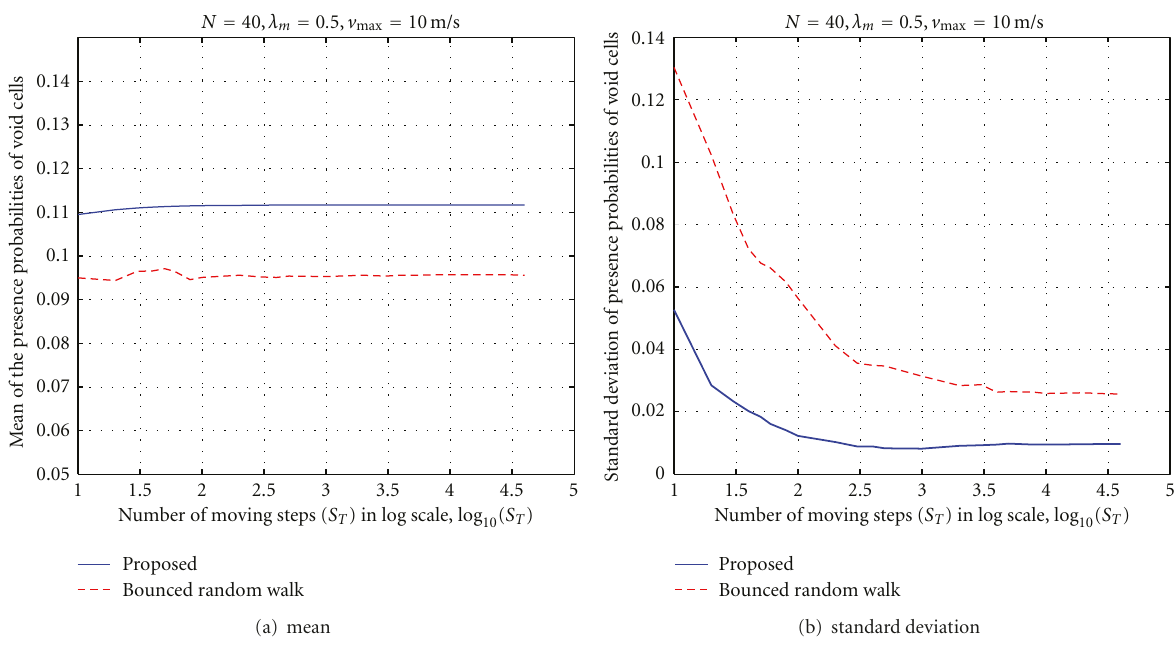
Figure 10: Mean and the standard deviation of presence probabilities at void cells versus the number of movement steps S T (in log scale) for proposed protocol and the bounced random walk mobility model, N = 40, λ m = 0 . 5, and v max = 10m/s. (a) Mean. (b) Standard deviation.